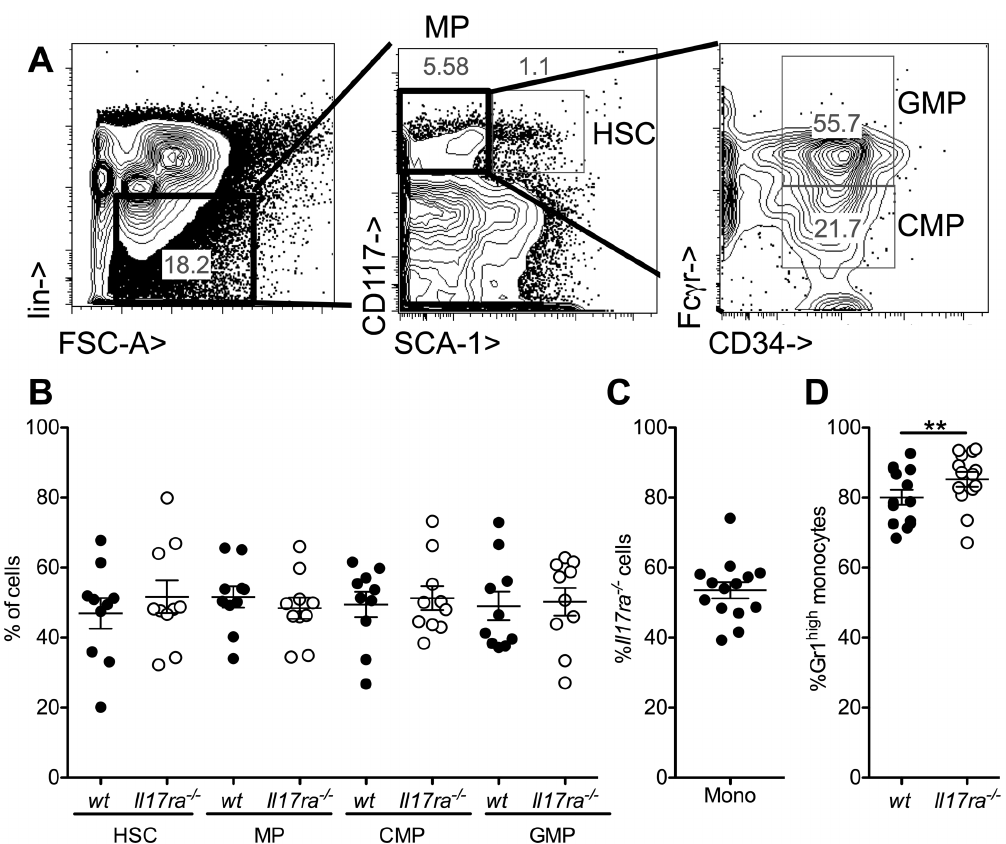
Figure 5. Il17ra -/- Gr1 low monocyte development in the bone marrow. ( A,B ) Bone marrow progenitors were defined among lineage negative cells as hematopoietic stem cells (HSC, CD117 + Sca + ), myeloid progenitors (MP, CD117 + Sca 2 ), common myeloid progenitors (CMP, CD34 + Fc c r 2 among MP) and granulocyte macrophage progenitors (GMP, CD34 + Fc c r + among MP). To assess the role of the IL-17 receptor on a cell specific level, the proportion of wt and Il17ra -/- cells at each stage was analyzed in mixed bone marrow chimeric mice (B, n=10 from 3 independent transplantations). ( C,D ) Similarly bone marrow CD11b + CD115 + monocytes were analyzed for genotype (C) and Gr1 high proportion (D) in wt and Il17ra -/- cells (n=10 from 3 independent transplantations, paired